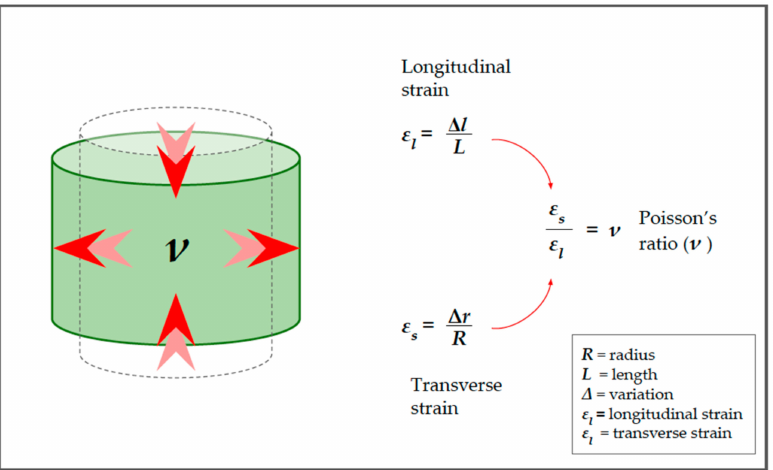
Figure 5. Poisson’s ratio. The relationship between the longitudinal and transverse deformation is called Poisson’s ratio and depends on the characteristics of the medium. Red arrows in the cylinder highlight the strain